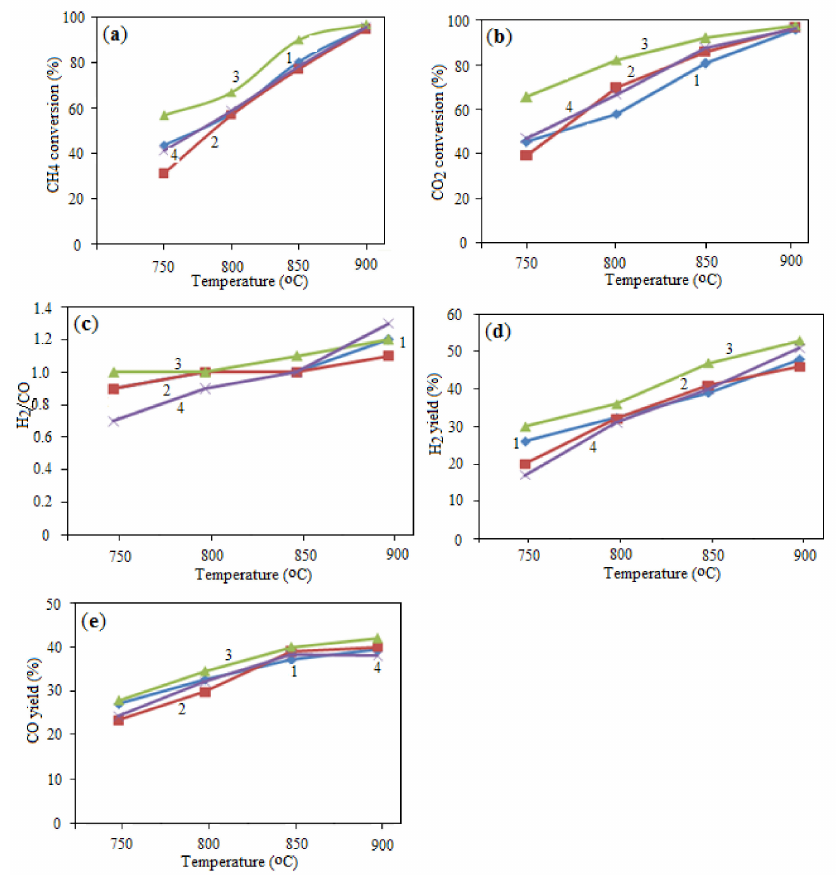
Figure 17. The dry reforming of methane on NiO–Al–Al 2 O 3 catalysts prepared by the impregnation